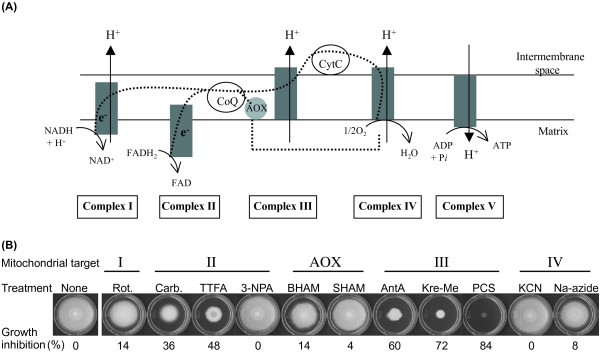
Targeting the mitochondrial respiratory chain. (A) Schematic representation of mitochondrial respiratory chain (Adapted from [78] and [22]. CoQ, Coenzyme Q; CytC, Cytochrome C; e-, Electrons; Dashed lines, Electron flow. (B) Differential antifungal efficacy of inhibitors (0.1 mM) of mitochondrial respiration targeting complexes I to IV and alternative oxidases (AOX), tested in Aspergillus fumigatus AF293. Results indicated that targeting complex II or III by using carboxin, TTFA, antimycin A, kresoxim methyl or pyraclostrobin resulted in higher inhibition of fungal growth than targeting other complexes (%: Growth inhibition rate, SD < 5%). Rot, Rotenone; Carb, Carboxin; TTFA, Thenoyltrifluoroacetone; 3-NPA, 3-Nitropropionic acid; BHAM, Benzhydroxamic acid; SHAM, Salicylhydroxamic acid; AntA, Antimycin A; Kre-Me, Kresoxim methyl; PCS, Pyraclostrobin; KCN, Potassium cyanide; Na-azide, Sodium azide. I to IV, complexes I to IV of mitochondrial respiratory chain; AOX, Alternative oxidases.